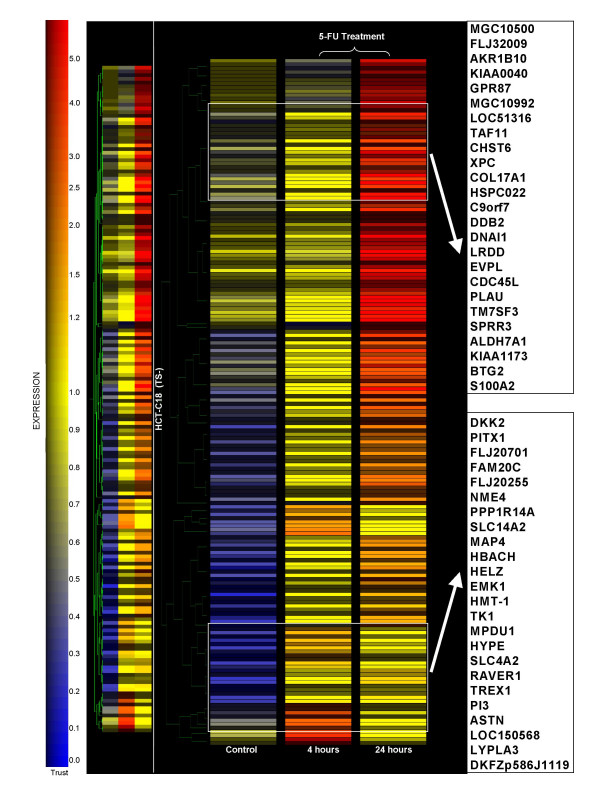
Clustering analysis of predictive marker genes for TS independent cytotoxicity in HCT-C18 (TS-) cells (Lane 1) treated with 10 μM 5-FU for 4 hrs (Lane 2) and 24 hrs (Lane 3) via One-way ANOVA analysis with p < 0.05.